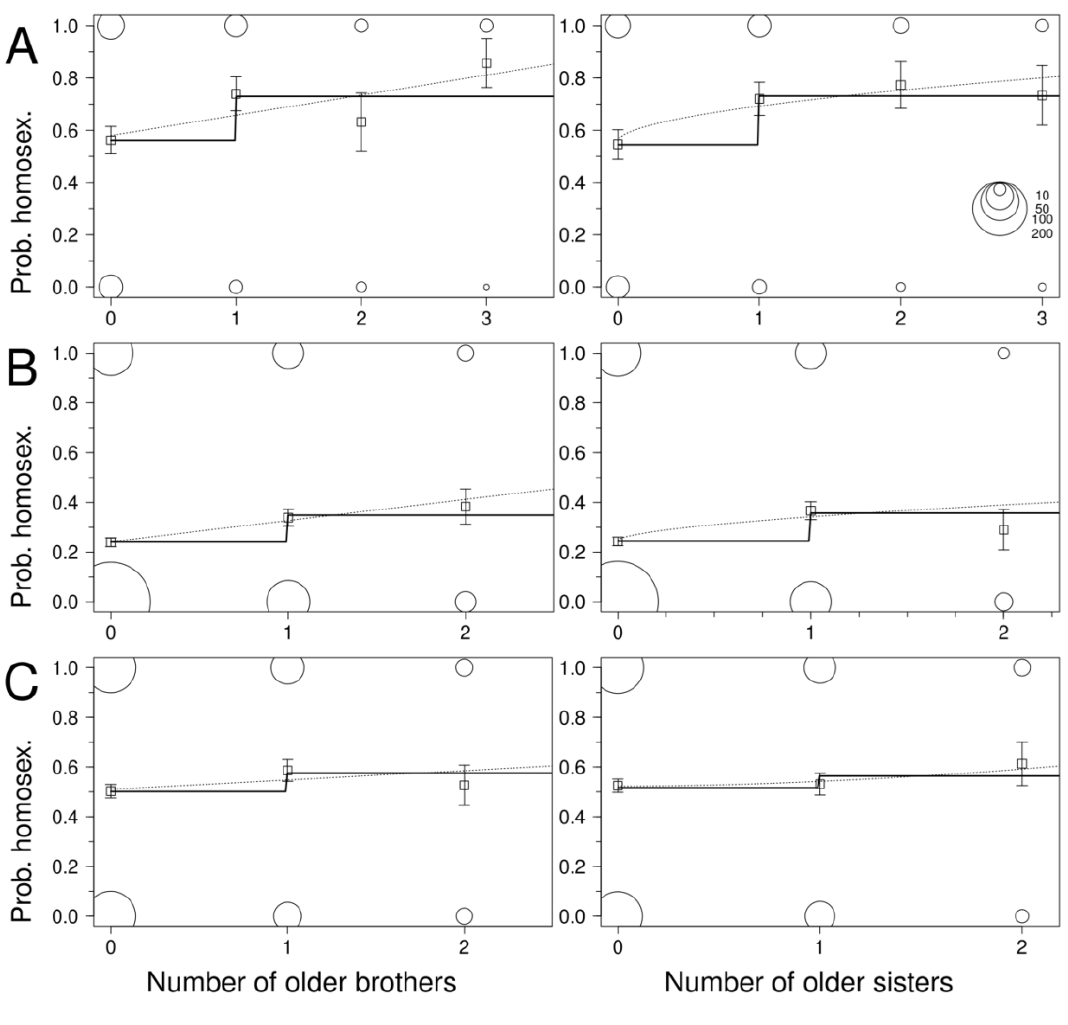
Figure 3. Modelling the older sibling effect. Data for the three datasets are presented (A: Indonesia; B: Greece; C: France), for each type of older siblings (left: older brothers; right: older sisters). The solid lines correspond to function 7. The dotted lines correspond to function 5 (left panels) or function 4 (right panels). The number of observations for each older older sibling category (at 0 on the y axis for heterosexuals, and at 1 on the y axis for homosexuals) is represented as a circle with an area proportional to sample size, according to the reference legend in the top-right panel. The frequency of homosexuals is depicted as a square, with the corresponding +/- SE range. Data with elevated number of older siblings (A: more than 3; B-C: more than 2) are not